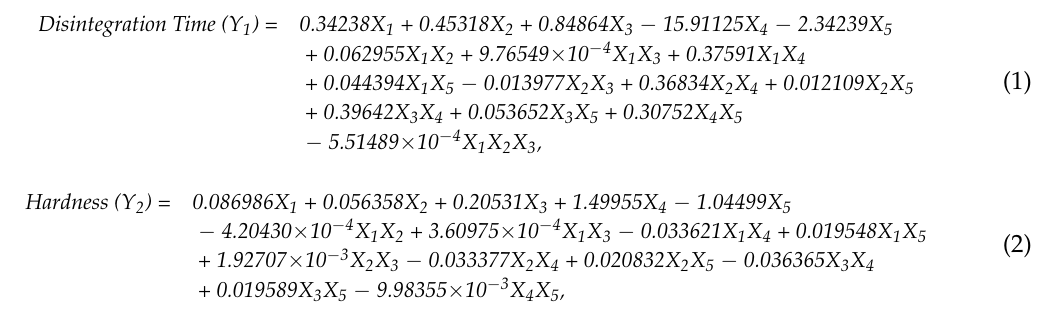
Table 2. Experimental design of herbal tablet formulation containing 50% of Wuzi Yanzong dry powder extract with five control factors (%, w / w ) and the resulting responses, disintegration time, and hardness. CCS Cros. Run (%) (%)